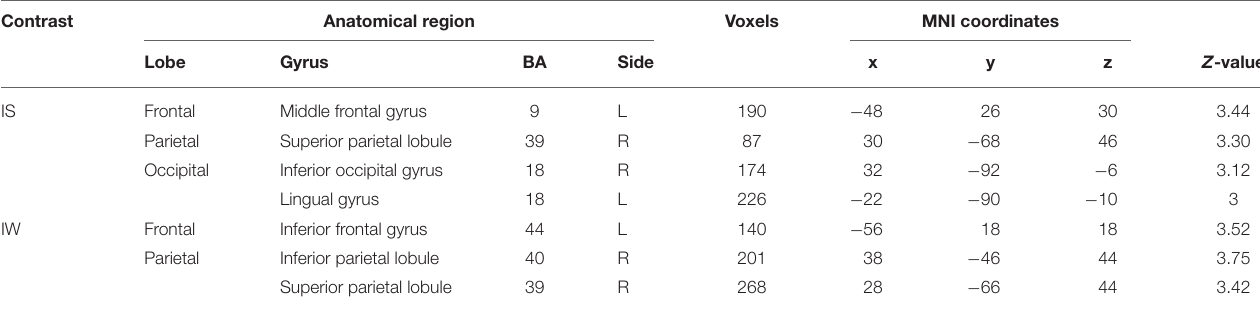
IW vs. Rest Frontal Medial frontal gyrus 32